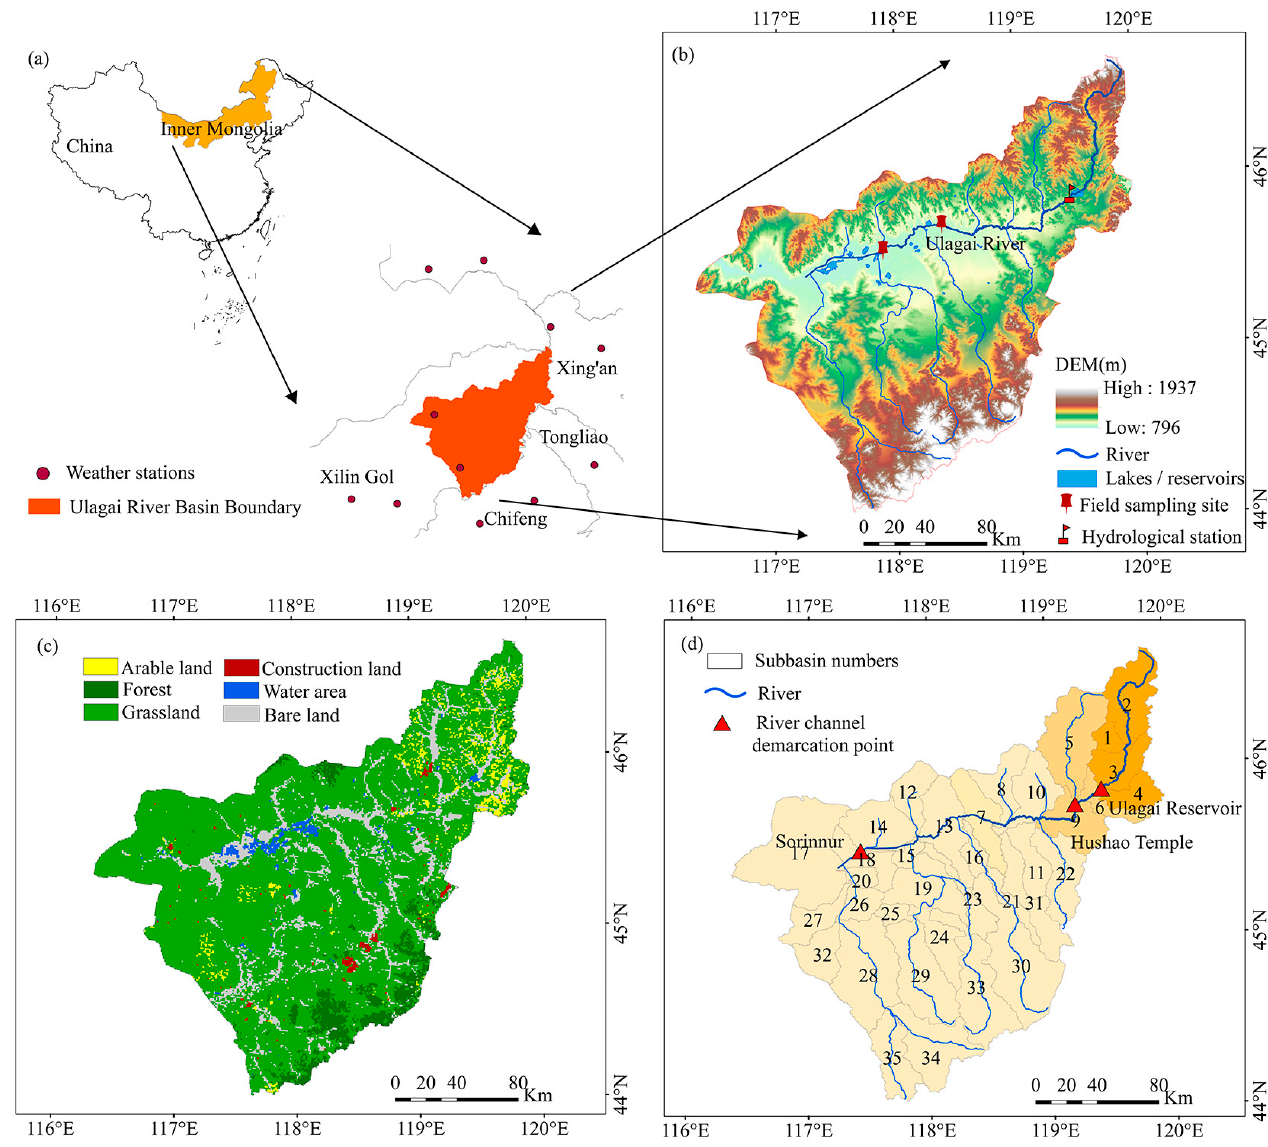
Figure 1. Overview map of ( a ) geographic location, ( b ) elevation, ( c ) land use/cover, and ( d ) subbasin delineation of the URB.